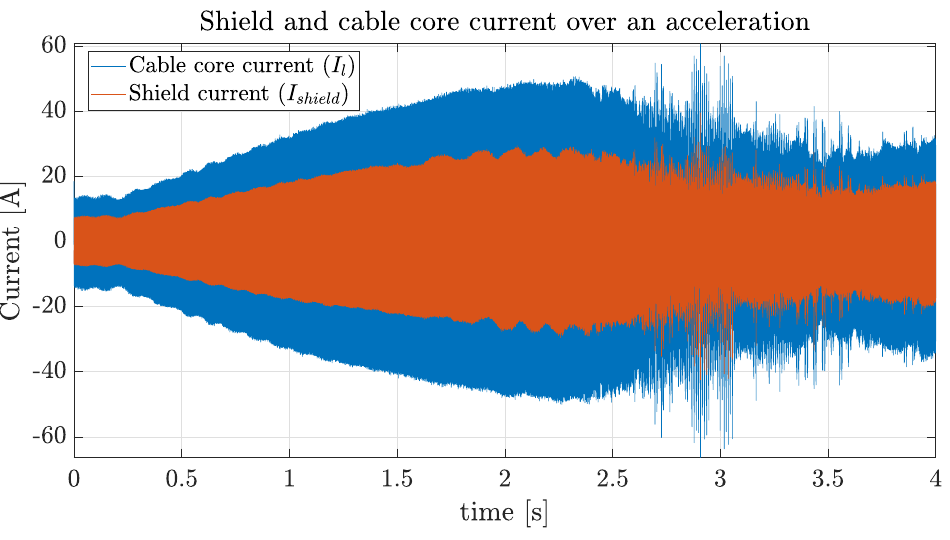
Figure 16. Measured shield and cable core current in the frequency range of 10 Hz to 150 kHz in the time domain on a 50 mm 2 copper cable, assembled between the HV-distributor and the front inverter, over an acceleration cycle ranging from 0 to 8000